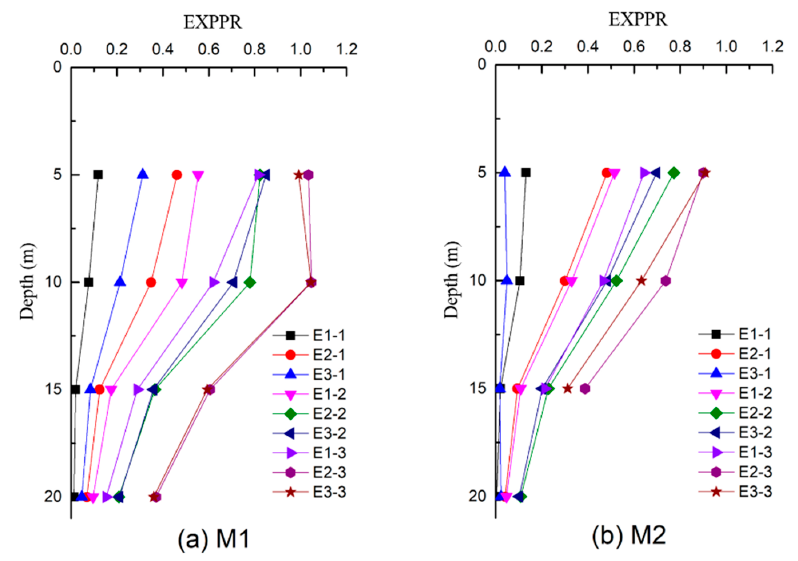
Figure 7. Maximum excess pore pressure ratio along the depth:( a ) medium dense model, M1; ( b ) dense model, M2.